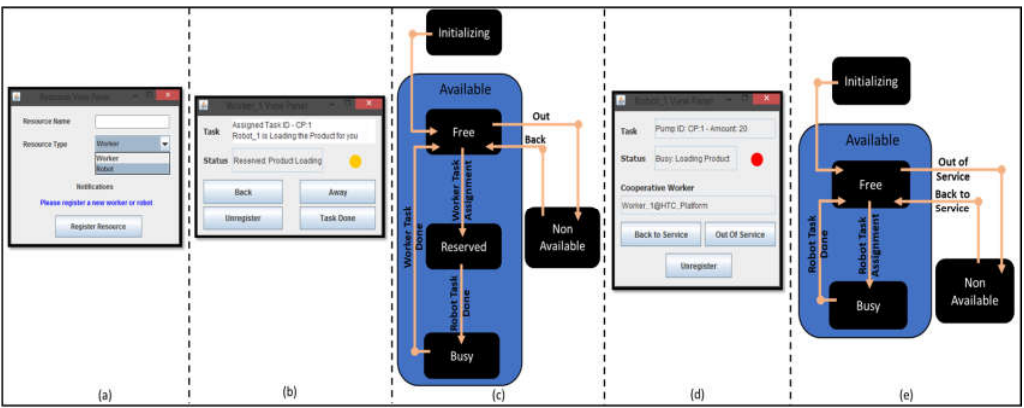
Figure 7. ( a ) OH (Operational Holon) User Interface; ( b ) ROH (Robot Operational Holon) User Interface; ( c ) ROH State-Machine; ( d ) WOH (Worker Operational Holon) User Interface; ( e ) WOH State-Machine.